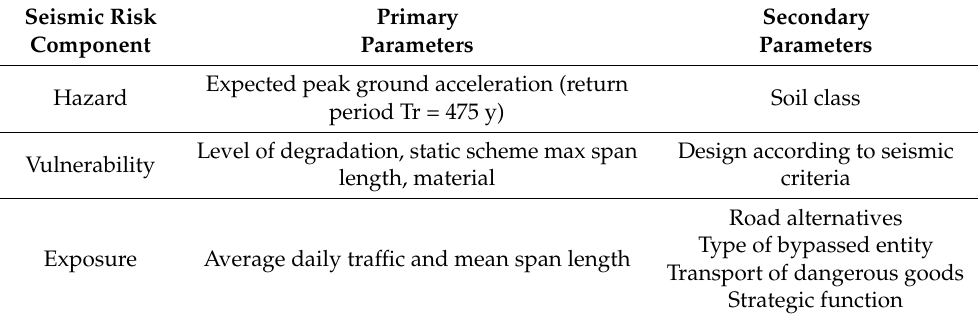
Table 4. Parameters influencing seismic